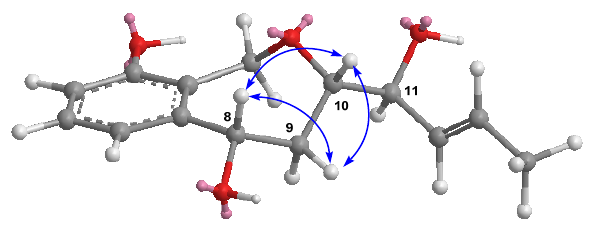
Figure 3. Key ROESY correlations of compound 4 .